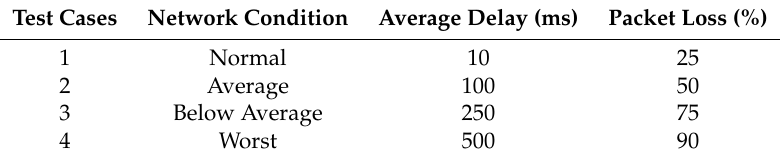
Table 2. Test cases for evaluation in non-RT and RT test